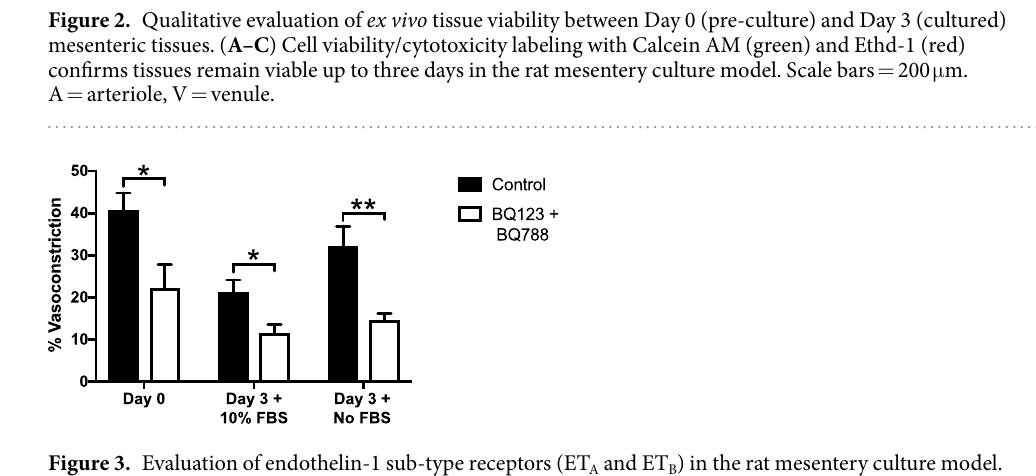
Figure 3. Evaluation of endothelin-1 sub-type receptors (ET A and ET B ) in the rat mesentery culture model. Comparison of arteriole constriction responses to 20 nM ET-1 in the presence of BQ-123 and BQ-788 antagonists. The statistically significant difference between Control and BQ-123 + BQ-788 for Day 0 (pre- culture) and Day 3 (cultured) groups suggests the endothelin-1 sub-type receptors (ET A and ET B ) remain functional in the rat mesentery culture model after three days in culture. Black and white bars represent the Control and BQ-123 + BQ-788 groups respectively. * and ** indicates a significant difference of p < 0.05 and p < 0.01 by two-tailed Student’s